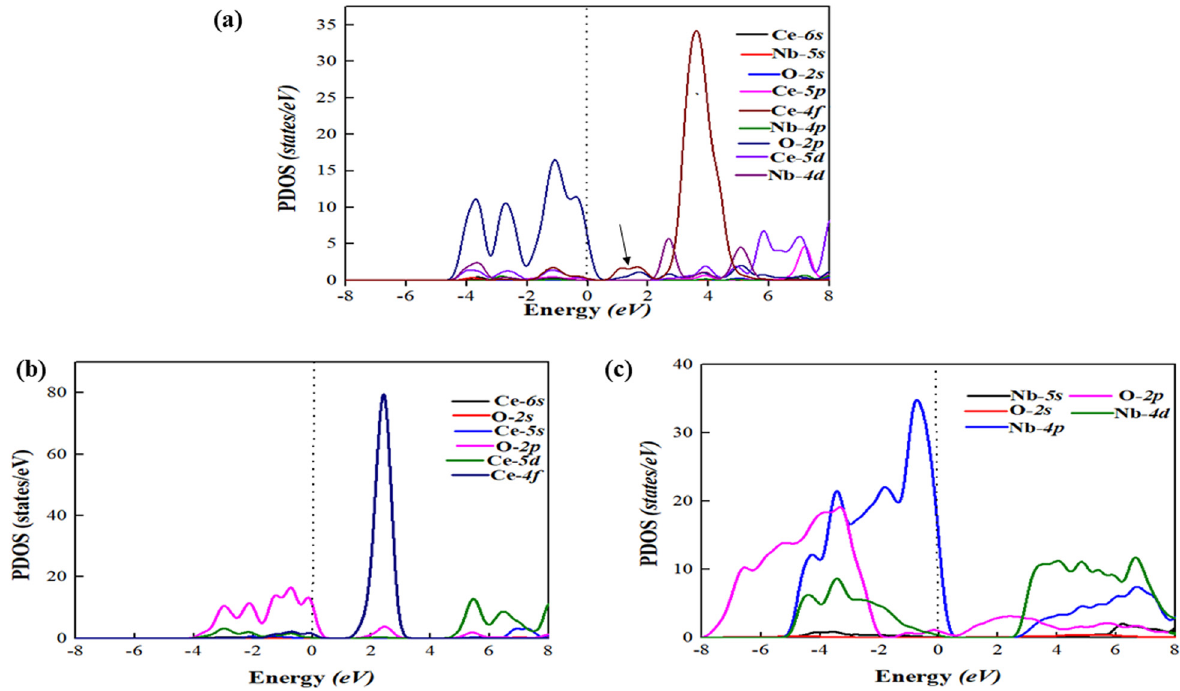
Figure 10: PDOS plots of ( a ) Nb - doped CeO 2 , ( b ) un - doped CeO 2 , and ( c ) Nb 2 O 5